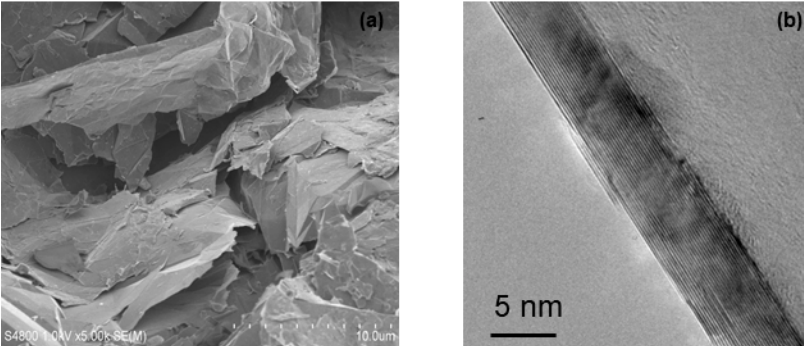
Figure 1. ( a ) SEM visualization of GnP; ( b ) TEM visualization of GnP.